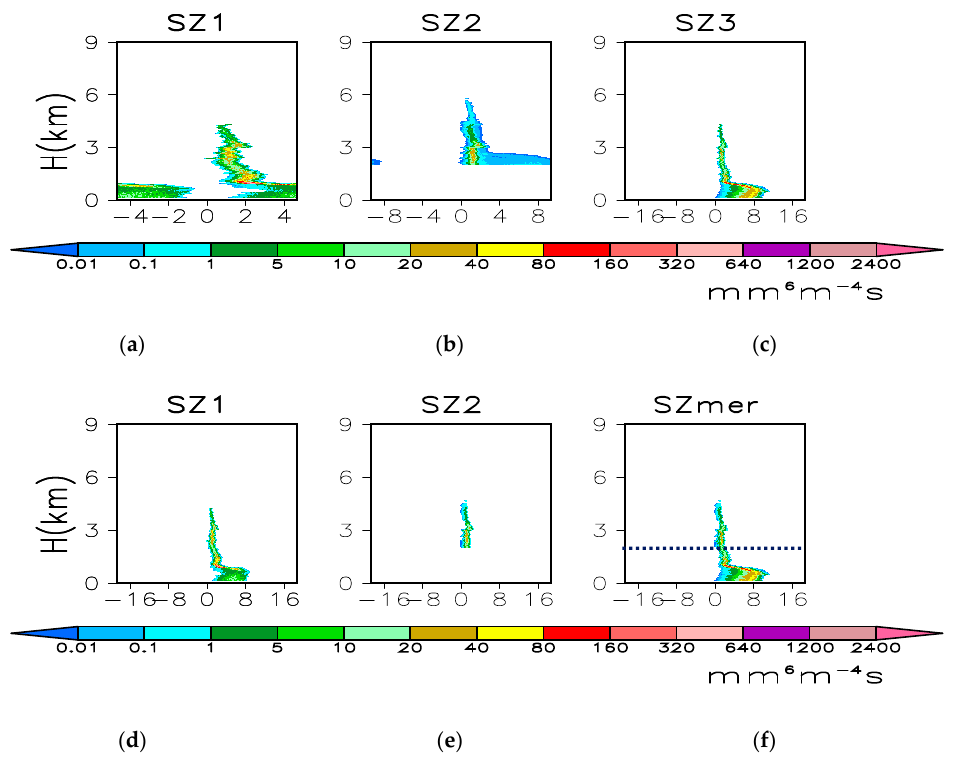
Figure 5. Raw reflectivity spectra (SZ) alone with the 85th beam by ( a ) M1, ( b ) M2, ( c ) M3; the quality